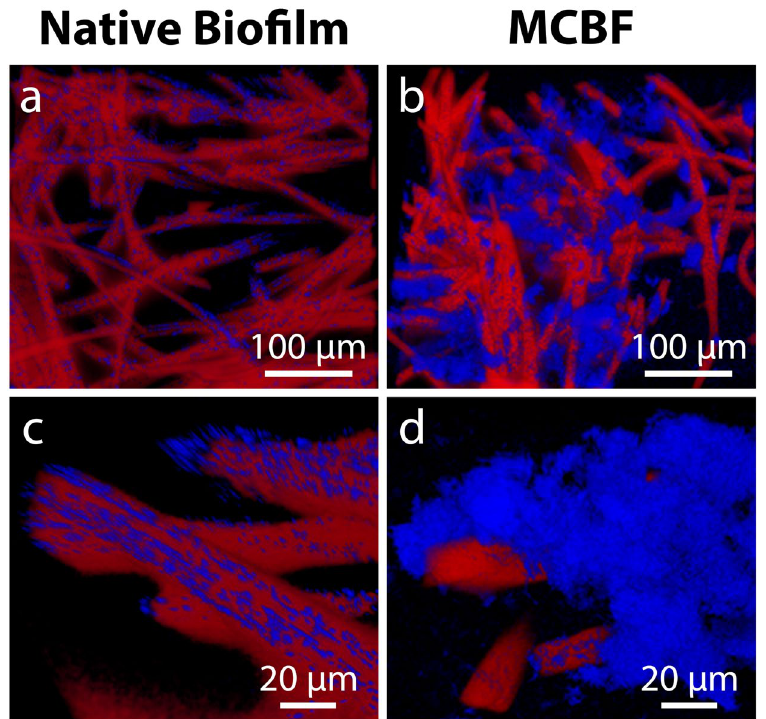
Figure 3. Multilayer conductive bacterial-composite films (MCBFs) are thicker than native S. oneidensis MR-1 biofilms on unmodified CF (UCF). Confocal microscopy images of cross sections of ( a and c ) native biofilm on UCF and ( b and d ) MCBF. Red color indicates CF and blue S. oneidensis